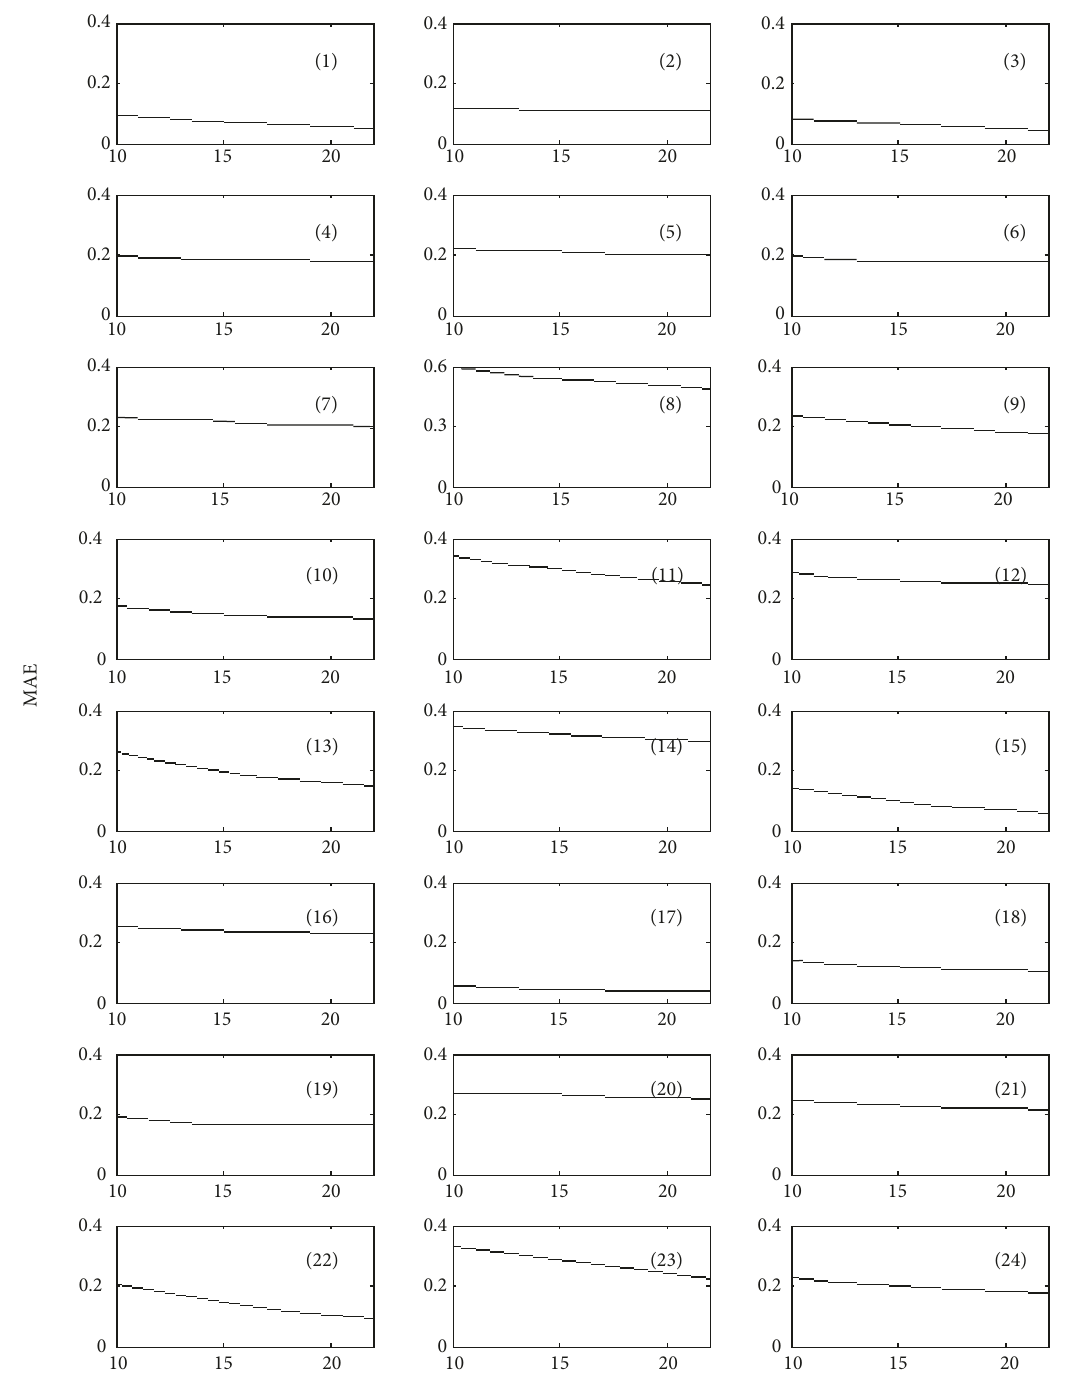
Figure 6: Change of MAE by the number of sampling sites: (1)-(23) corresponding to sampling site p1-p23 when the site is selected in cross- validation and (24) is the overall